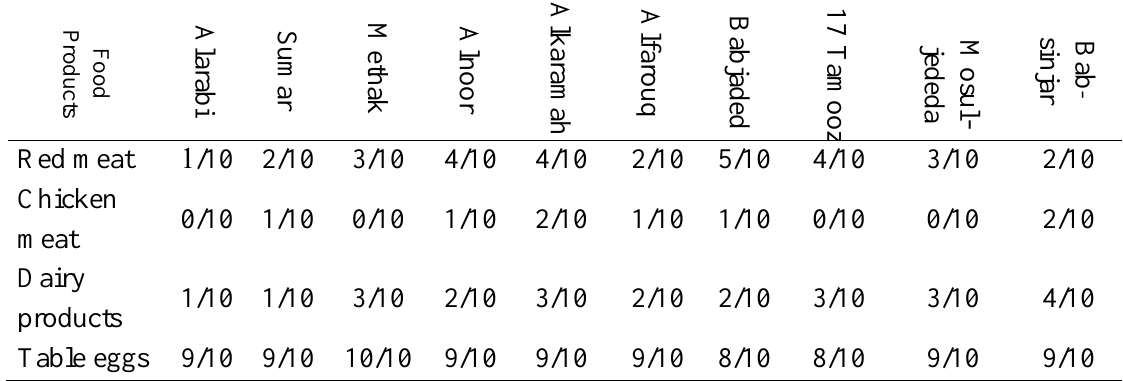
Table 2: Number of food products of animal origin displayed at room temperature: